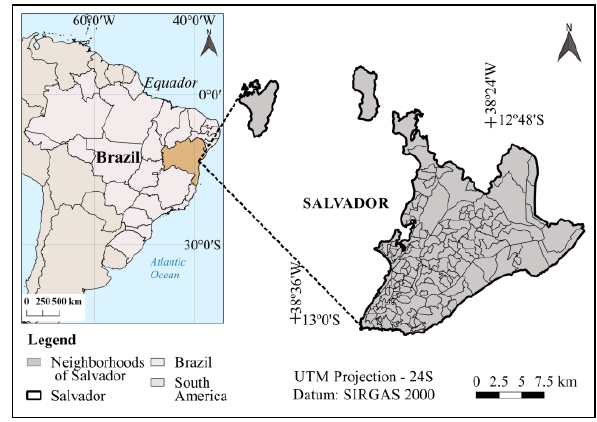
Figure 1 . Location map of study area. Salvador city (left) and the country Brazil (right). Data source: Brazilian Institute of Geography and Statistics (IBGE, 2019) and Secretariat of Development and Urbanism (SEDUR,